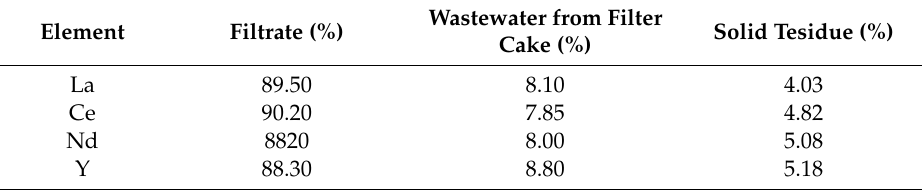
Table 5. Metal distribution in filtrate, wastewater from filter cake and solid